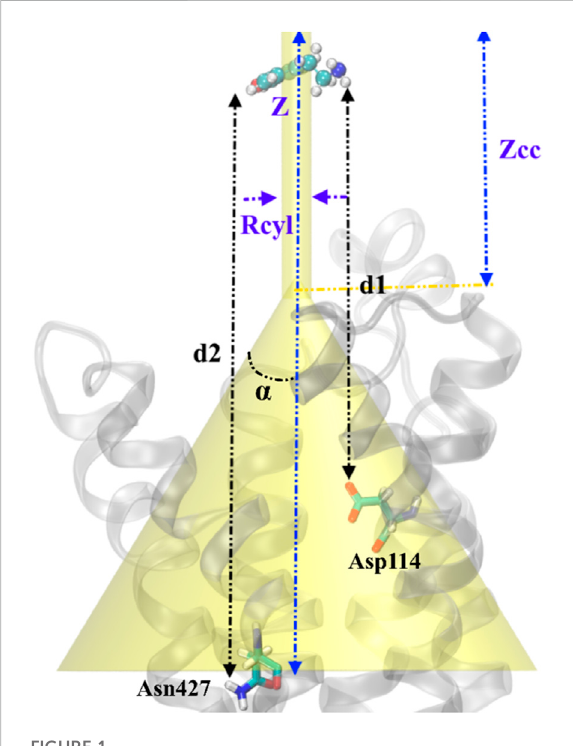
FIGURE 1 Schematic representation of the funnel restraint potential describes the setup of FM simulation in our work. Binding/ unbinding axis, Z de fi nes the binding path of TA from top to inside of transmembrane protein. The distance between cone and cylinder shape is de fi ned as Z cc , and R cyl is the radius of the cylindrical section. Two CVs are de fi ned as the distance between the – NH 2 group in TA and Asp114 (d1) and the distance between the – OH group in TA and Asn427 (d2). TA represents a ball and sticks while the protein shows in the